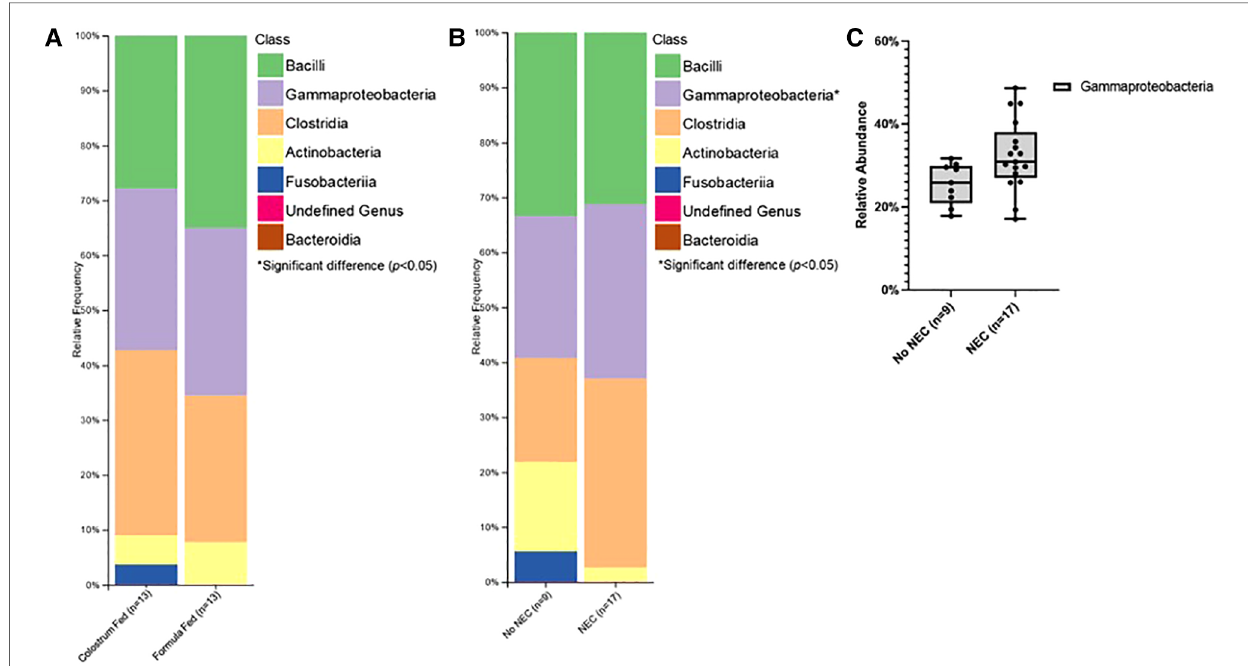
FIGURE 7 Class level taxonomic abundance. Class level taxa distribution within ( A ) feeding regimen and ( B ) occurrence of NEC. Bars represent mean relative percentage of each corresponding bacterial class. ( C ) Distribution of signi fi cantly different classes within incidence of NEC as box and whisker plots that denote minimum, maximum, and interquartile range values. For all relative abundance data, pairwise comparisons between groups were made using the Kruskal-Wallis test ( p